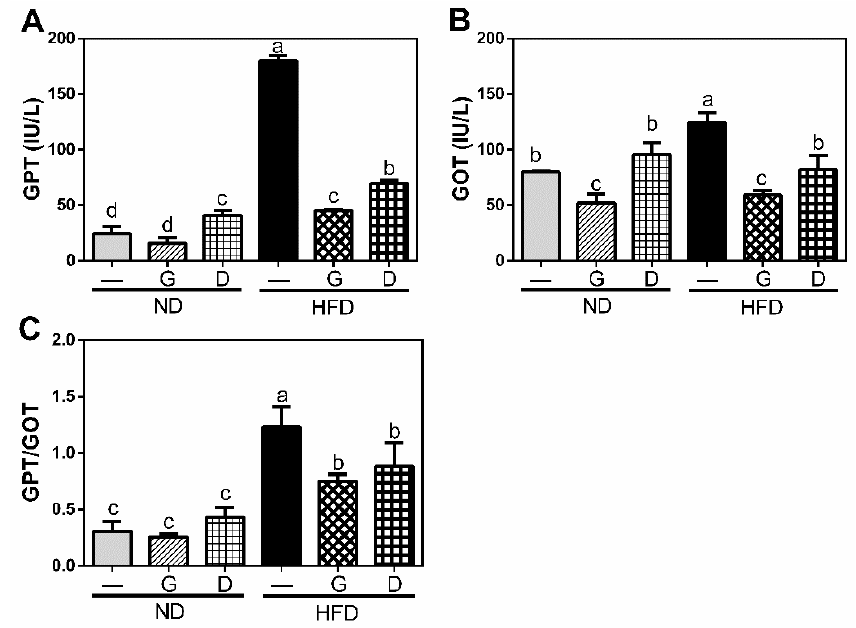
Figure 2. E ff ects of garlic supplementation on serum level of glutamic-pyruvic transaminase (GPT) ( A ), glutamic-oxaloacetic transaminase (GOT) ( B ), and the ratio of GPT / GOT ( C ). The data represent the mean ± SD of five mice. G: garlic; D: Dextrin. Columns with di ff erent letters significantly di ff er ( p <